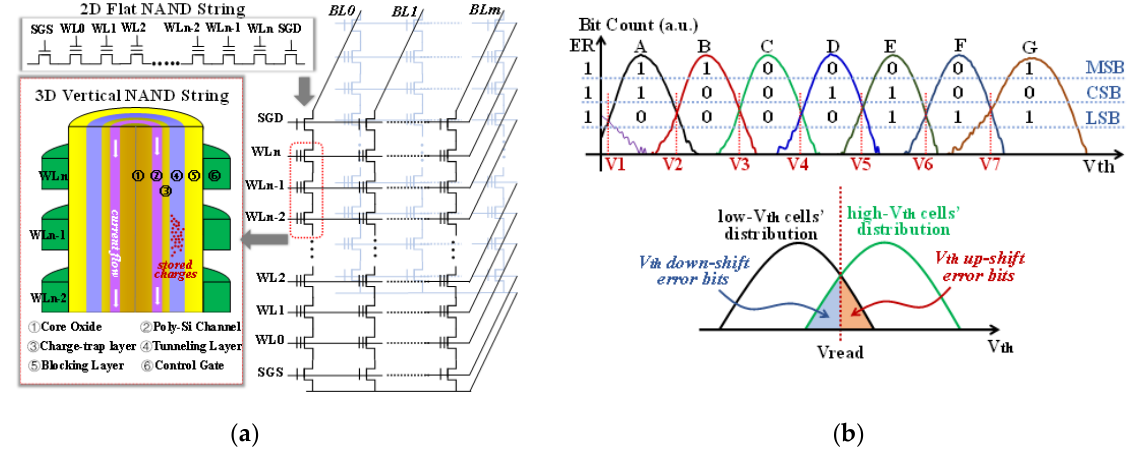
Figure 1. ( a ) A schematic of a 2D NAND string and a 3D NAND string, wherein a 3D NAND cell unit contains core oxide, poly-Si channel, tunneling layer, CT layer, blocking layer, a and control gate; ( b ) TLC operations by storing 3 bits in each cell at three pages: MSB, CSB, and LSB; V1~V7 denote read voltages with the definitions of V th down-shift and up-shift errors.